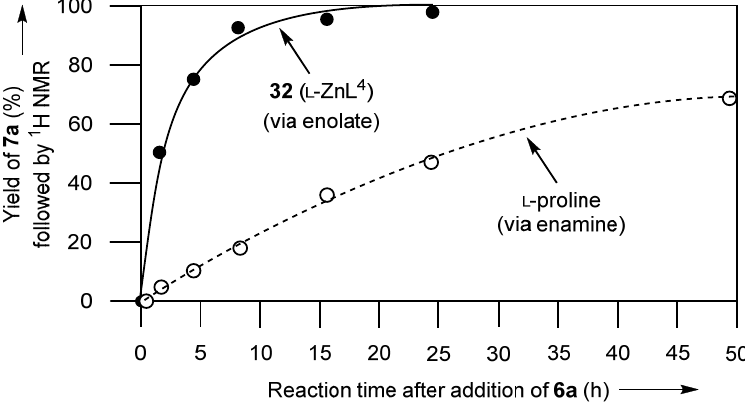
Figure 5. ( a ) ORTEP (Oak Ridge Thermal Ellipsoid Plot) of drawing of 48 ( L -ZnL 16 (NO ) ); thermal ellipsoids are set at 50% probability; ( b ) Coordination-bond 3 2 ) ). A Zn 2+ ion is 6-coordinated by these nitrogen atoms of a lengths in 48 ( L -ZnL 16 (NO 3 2 cyclen ring, one nitrogen atom of the side chain, and two oxygen atoms of the NO anion are omitted for All of the hydrogen atoms and one NO 3